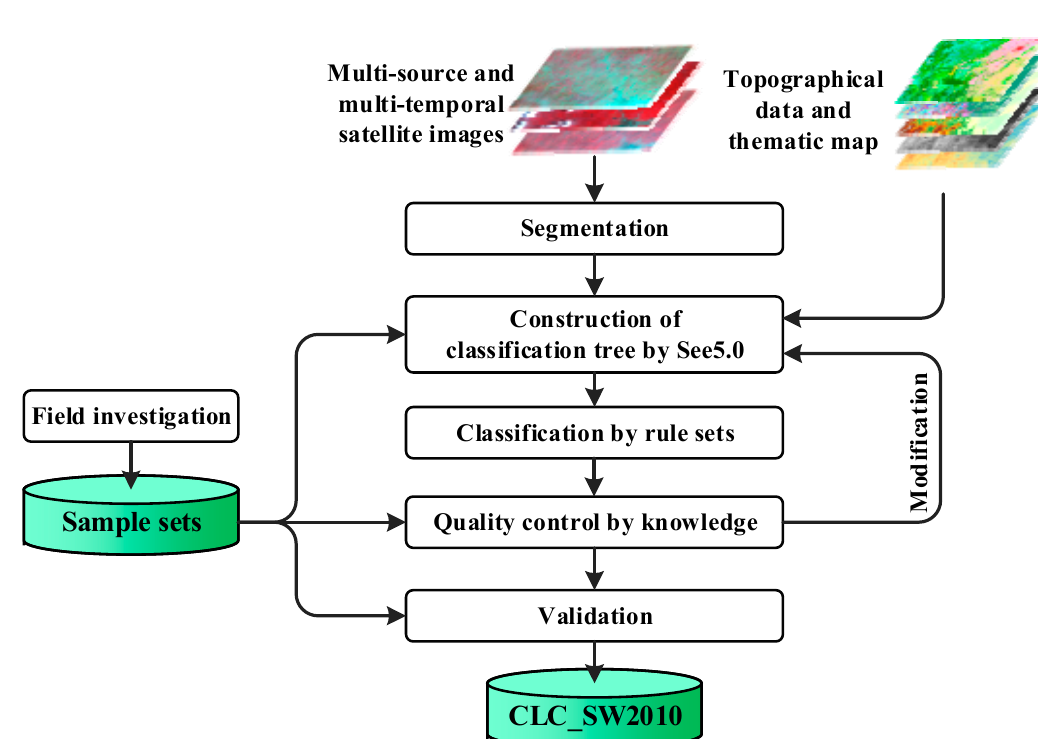
Figure 2. The flowchart of the HC-MMK (Hierarchical Classification based on Multi-source and Multi-temporal data and geo-Knowledge) approach.